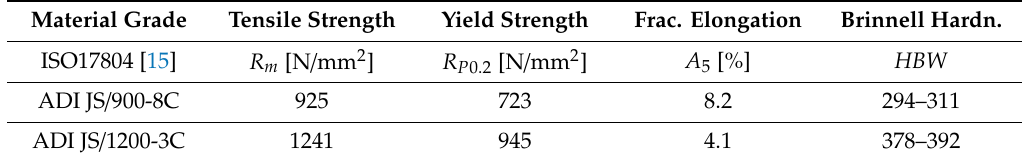
Table 2. Mechanical Properties of ADI JS / 900-8 and ADI JS /